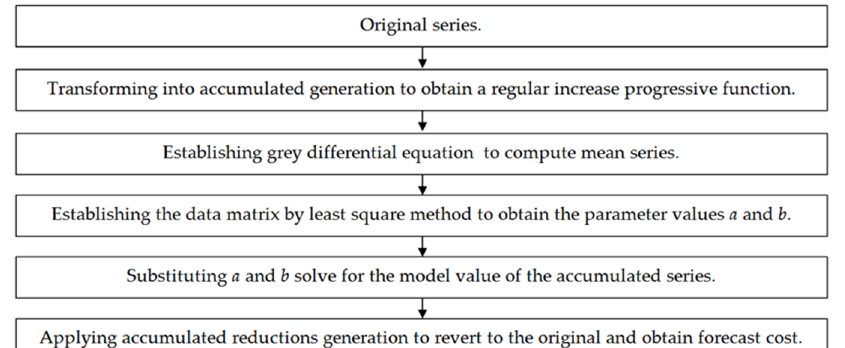
Figure 7. Forecasting process.